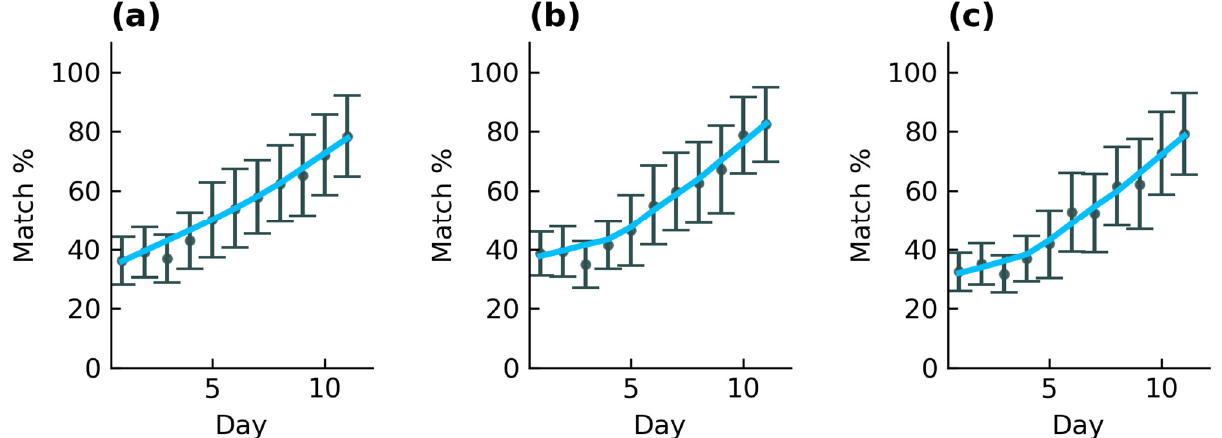
Figure 8. As in Figure 7, during nighttime.